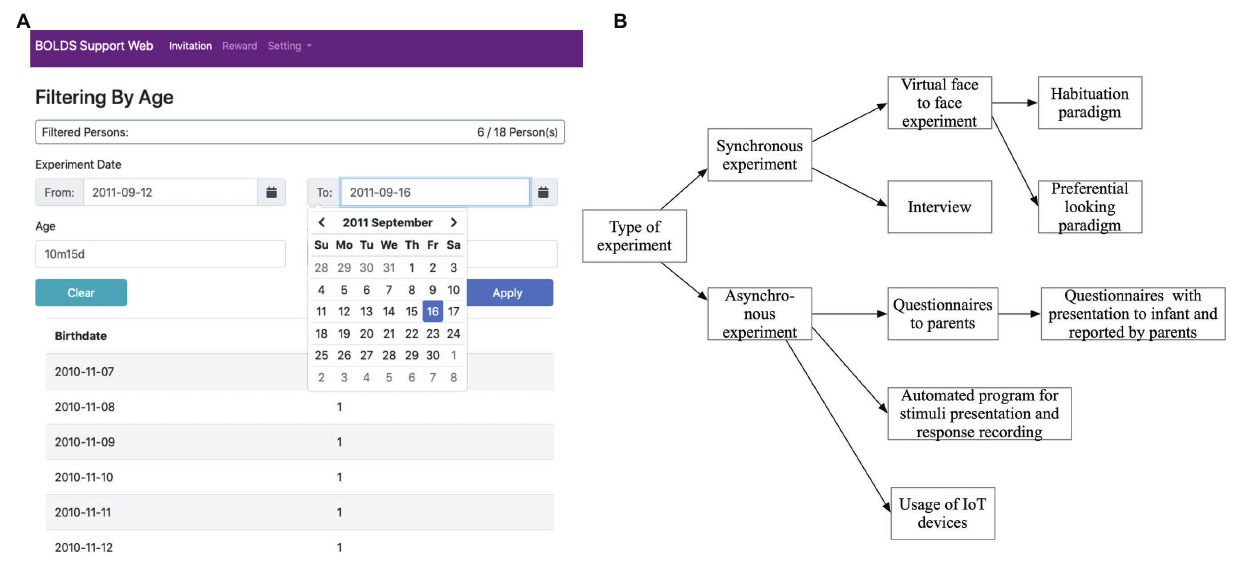
FIGURE 1 | (A) An example of an interface for the participant management system implemented with Java language. In this screen, experimenters can select target babies/children based on the scheduled experiment dates and expected participants’ age at the scheduled dates. (B) Type of experiment to be integrated with Baby’s Online Live Database